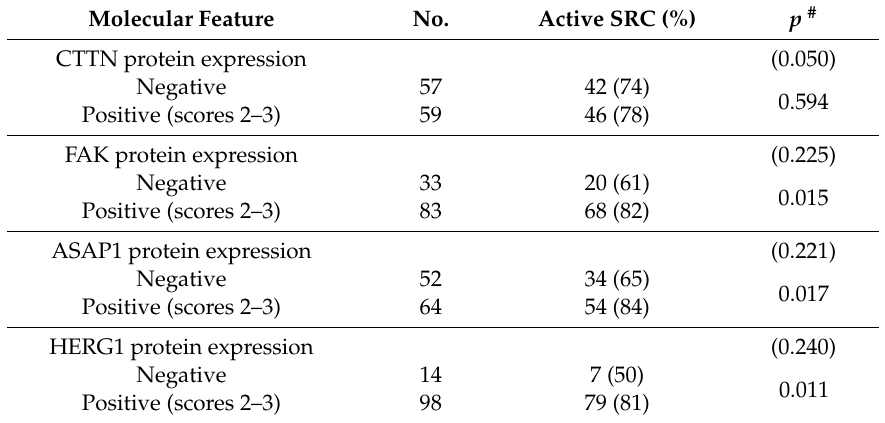
Table 3. Associations between the expression of active SRC and downstream SRC-related proteins.